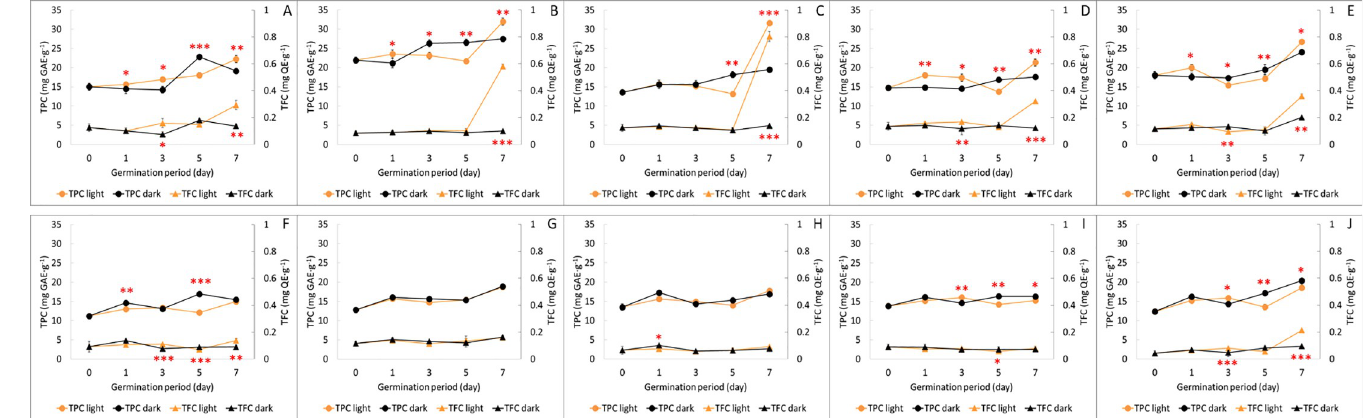
Fig 3. Changes in the total phenolic content and total flavonoid content of small-seeded (A–E) and large-seeded (F–J) soybeans during germination under light and dark conditions. Values are the mean of three replicate determinations (n = 3) ± standard deviation. Statistical significance was shown by a t-test between the germination under light and dark conditions at the each time point ( ��� p < 0.001, �� p < 0.01, � p < 0.05). A, Socheongja; B, Youngwoljwinuni B/G; C, Dawonkong; D, Yaksunkong; E, Youngwoljwinuni B/Y; F, Cheongja3; G, GWS 148; H, Daewonkong; I, GWS 140; J, Taekwangkong. GAE, gallic acid equivalents; QE, quercetin.